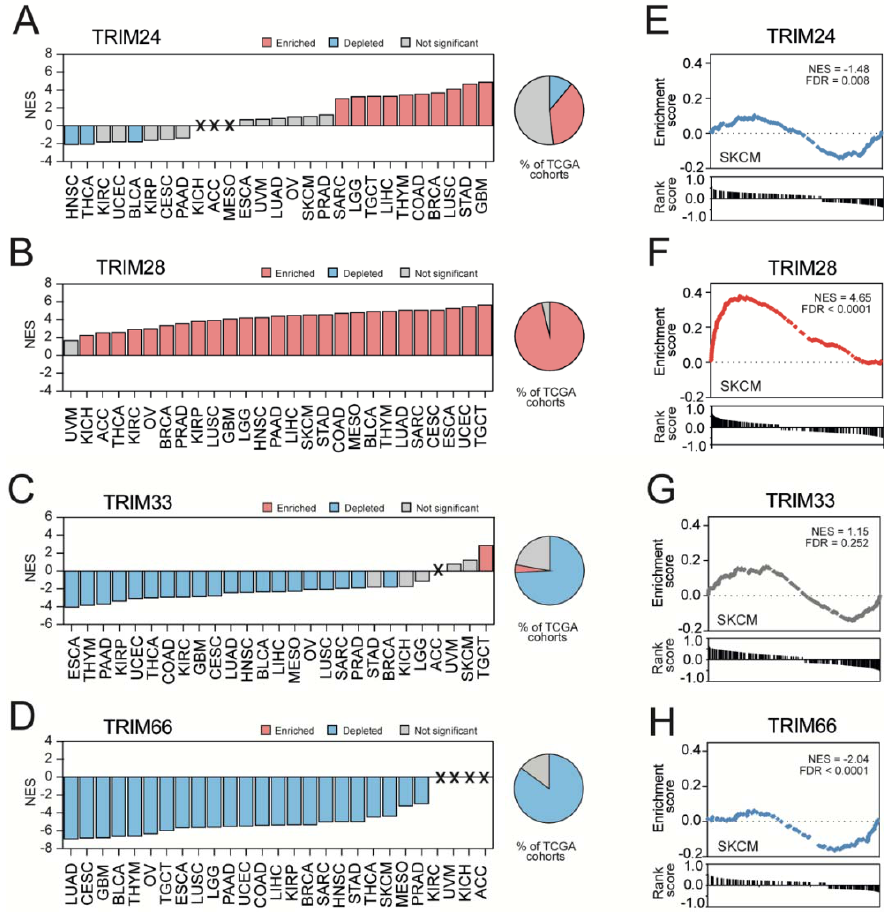
Figure 5. Stemness signature enrichment in transcriptome profiles associated with the expression of TIF1 family members. ( A–D ) The Gene Set Enrichment Analysis (GSEA) using significantly correlated genes for ( A ) TRIM24, (B) TRIM28, ( C ) TRIM33, or ( D ) TRIM66 expression was performed with the stemness signature (Wong_ESC_Core) as a reference. Bar — normalized enrichment score (NES); X — gene sets that did not reach the size threshold (at least 15 genes). Blue and red denote a significant depletion or significant enrichment, respectively. ( E , F ) The GSEA using transcriptome profiles associated with the expression of ( E ) TRIM24, ( F ) TRIM28, ( G ) TRIM33, and ( H ) TRIM66 in SKCM revealed significant enrichment with the Kim_Myc_targets gene signature. The GSEA results for the Kim_Myc_targets gene signature enrichment in other tumor types are shown in Figure S3.